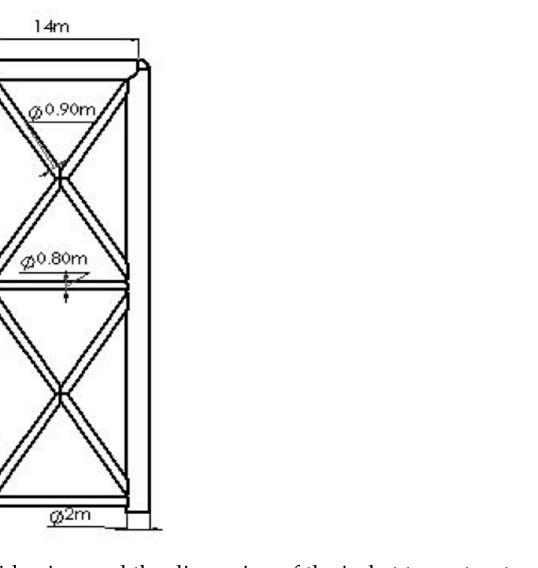
Figure 2. Side view and the dimension of the jacket type structure.